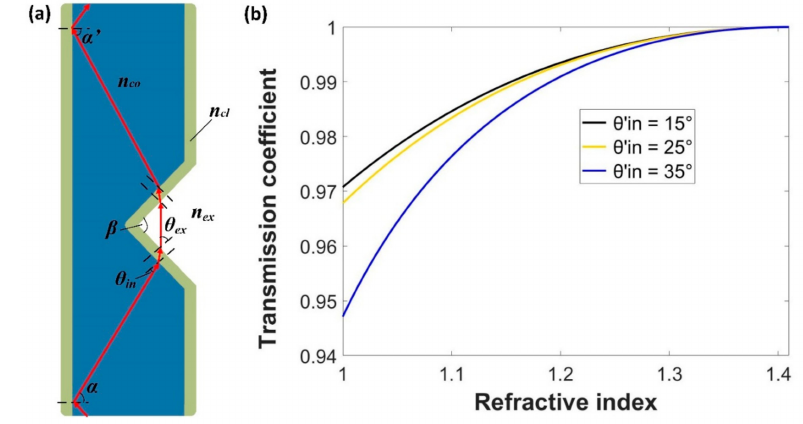
Figure 2. Diagram of the POF with one V-groove structure ( a ), and the effect of the refractive index of the medium in the V-groove region on the transmission coefficient for three different incident angles of θ (cid:48) in ( b